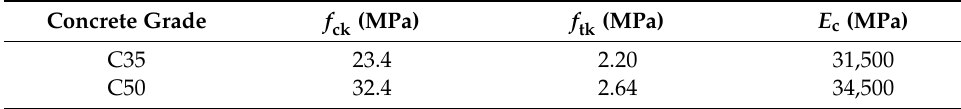
Table 5. Material properties of